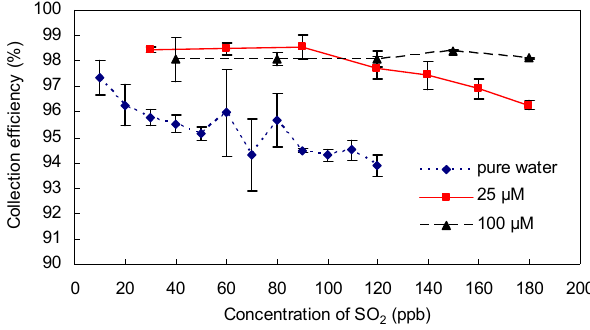
Fig. 3. Collection efficiencies of SO 2 by the WAD used in the GAC for three solutions with standard deviation labeled